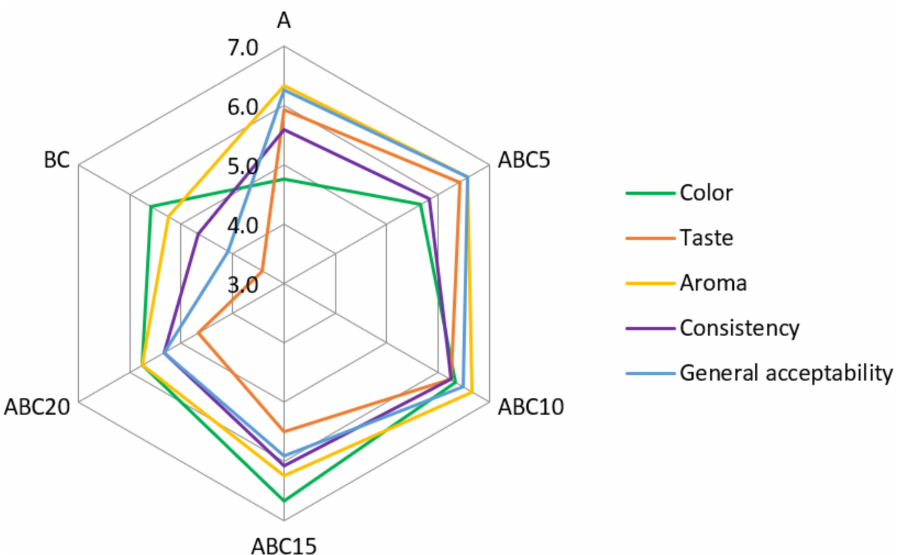
Figure 1. Sensory analysis of the apple, black chokeberry, and mixed juices. A—Apple juice; BC— black chokeberry juice; ABC5—mixed juice A:BC = 95:5 ( v / v ); ABC10—mixed juice A:BC = 90:10 ( v / v ); ABC15—mixed juice A:BC = 85:15 ( v / v ); ABC20—mixed juice A:BC = 80:20 ( v / v